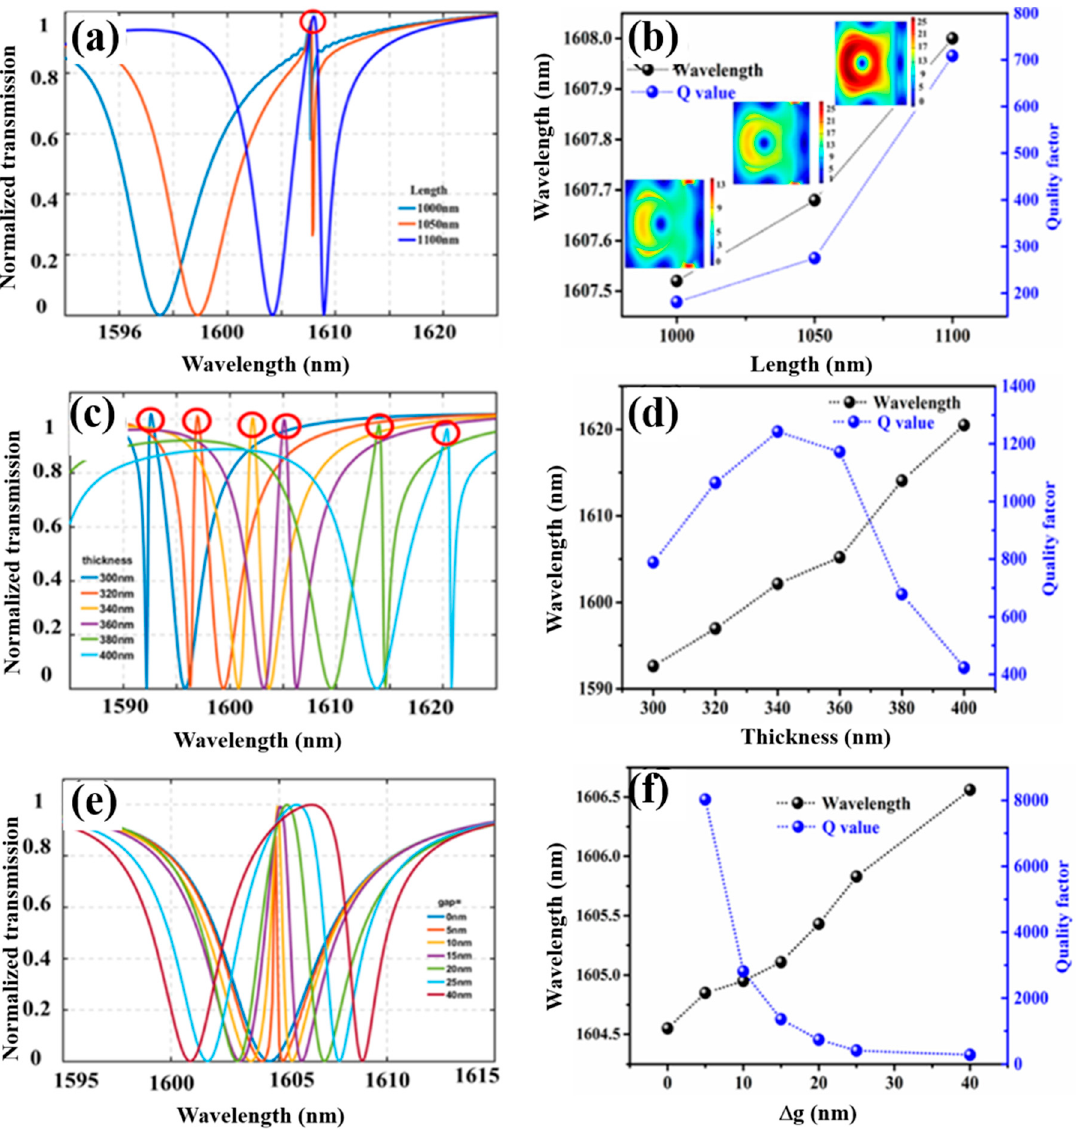
Figure 2. Normalized transmission of varying ( a ) the length of the LN bar L , while other parameters are fixed, with t = 360 nm, ∆ g = 20 nm, R = 350 nm, and w = 100 nm, ( c ) the TFLN thickness t , while other parameters are fixed, with L = 1100 nm, ∆ g = 20 nm, R = 350 nm, and w = 100 nm, ( e ) the asymmetric distance between the bar edges to the edges of the neighboring LN disks ∆ g = g 1 − g 2, while the other parameters are fixed, with L = 1100 nm, t = 340 nm, R = 350 nm, and w = 100 nm. The peak marked by the red circles are considered. Fano resonance peak wavelength and the corresponding resonance Q factor of varying, ( b ) the length of the LN bar (the insets show the field distribution along the middle of the disk), ( d ) the TFLN thickness, ( f ) the asymmetric distance between the bar edges to the edges of the neighboring LN disks ∆ g = g 1 − g 2.